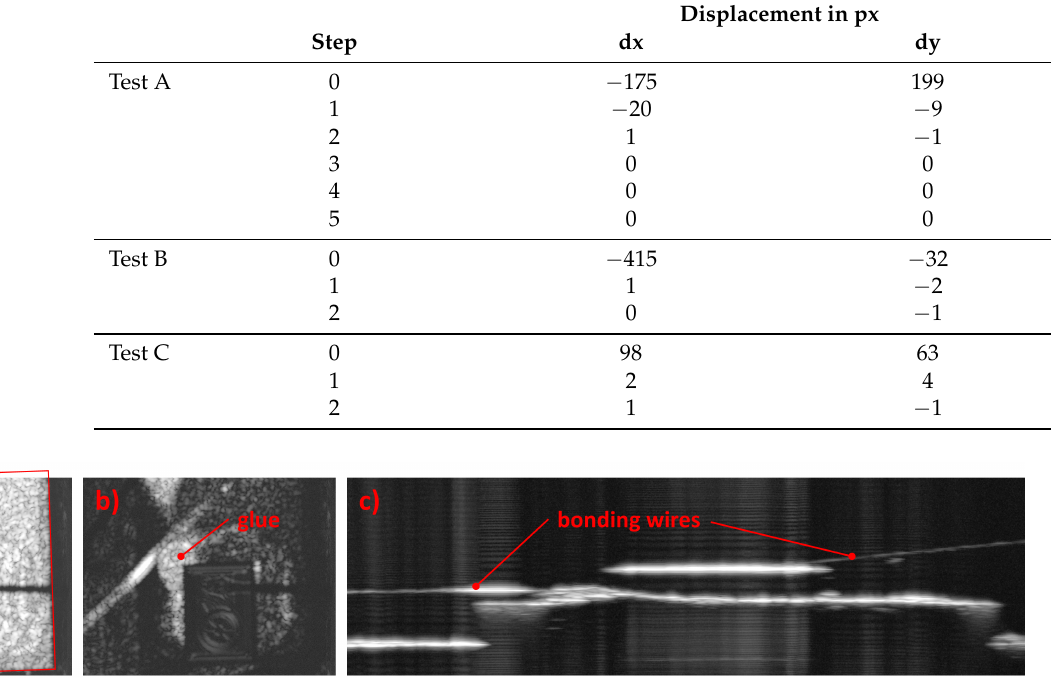
Figure 13. OCT images showing additional features. ( a ) En face sum image that shows how the LED was positioned on the die. ( b ) En face sum image showing the glue distribution between the LED and die. ( c ) B-scan sum image showing the positions and completeness of two bonding